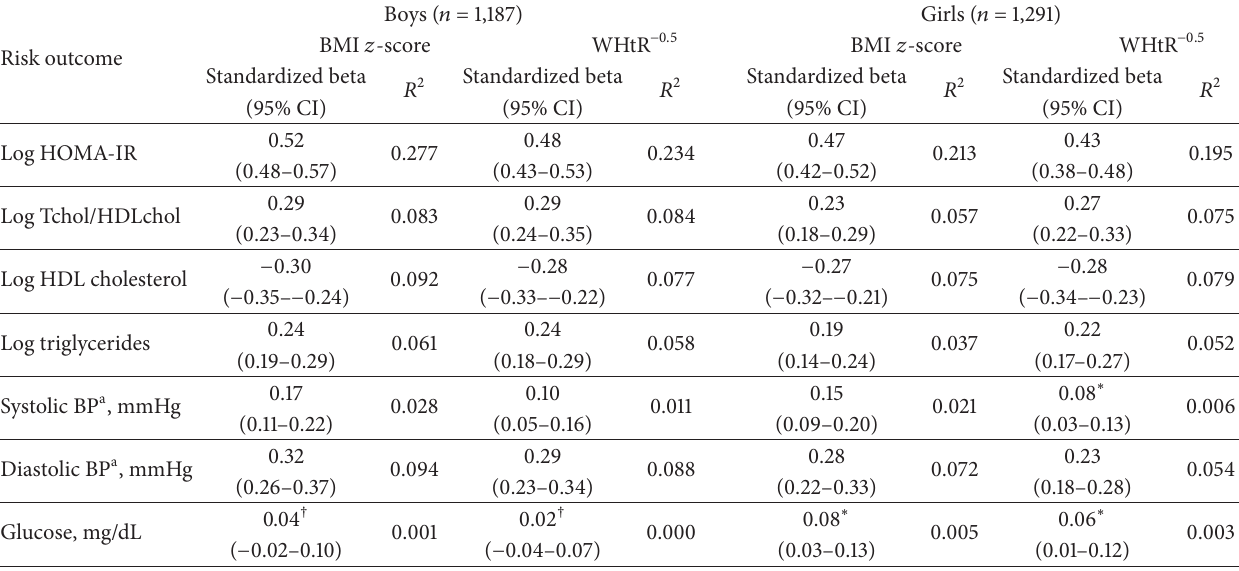
Table 3: Associations comparing standardized BMI 𝑧 -score with standardized WHtR for estimating risk variable outcomes among high- fatness students ( 𝑁 =